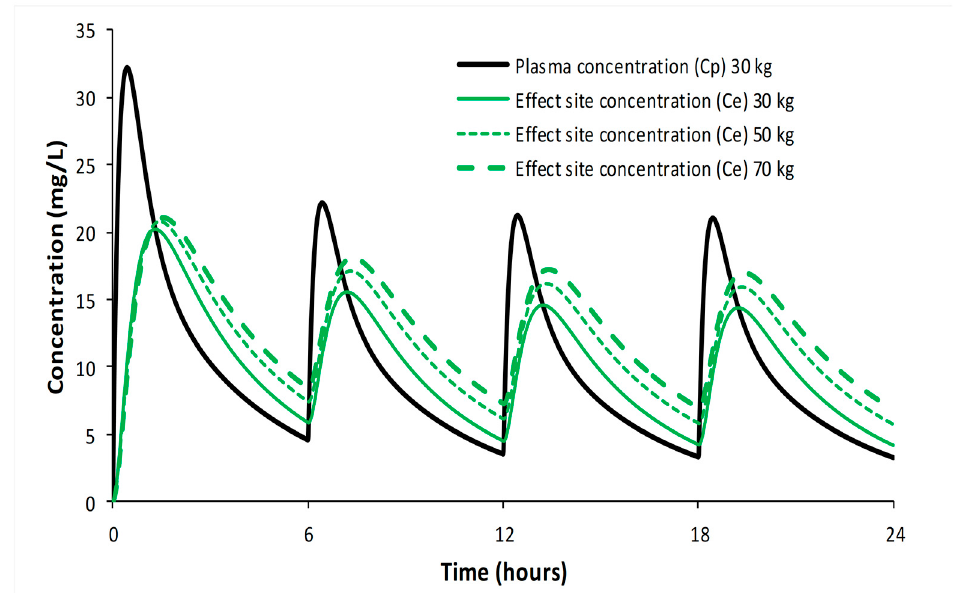
Figure 4. Simulated time–concentration profiles are shown for a loading dose of acetaminophen of 30 mg/kg in a 10-year-old, 30 kg child (FFM 24 kg, BMI 15.3 kg/m 2 ). Effect compartment concentrations for that child and obese children (weight 50 kg, FFM 33 kg, BMI 25.5 kg/m 2 and weight 70 kg, FFM 39 kg, BMI 35.7 kg/m 2 ) are shown after regular maintenance dosing of 15 mg/kg 6-hourly. Concentration increases as weight increases because clearance has a nonlinear relationship with